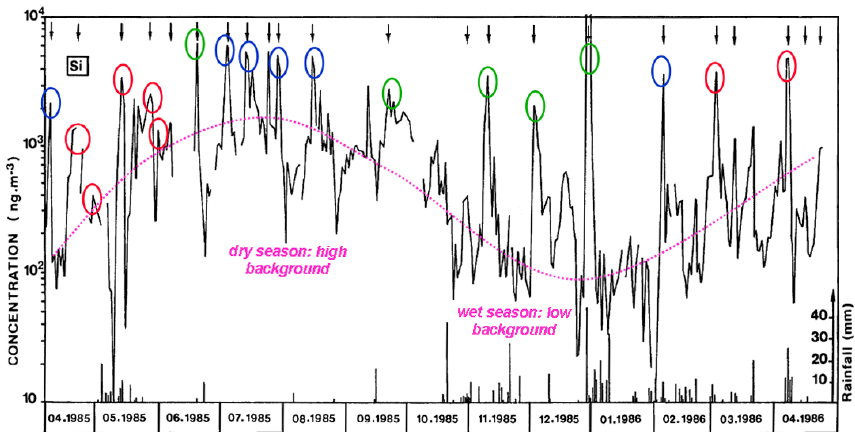
Fig. 2. Atmospheric concentration of particulate Si used as a tracer of African dust and rainfall as observed on a quasi daily basis in NW Corsica from April 1985 to April 1986. The pink dotted curve features the contrasted background between the dry and wet seasons in Corsica. Arrows indicate African dust outbreaks identified by air mass back-trajectories. When clearly identified, dust source regions are indicated by colored ovals: south of 30 ◦ N in red; Morocco-western Algeria in green; eastern Algeria-Tunisia-western Lybia in blue (after Bergametti et al.,